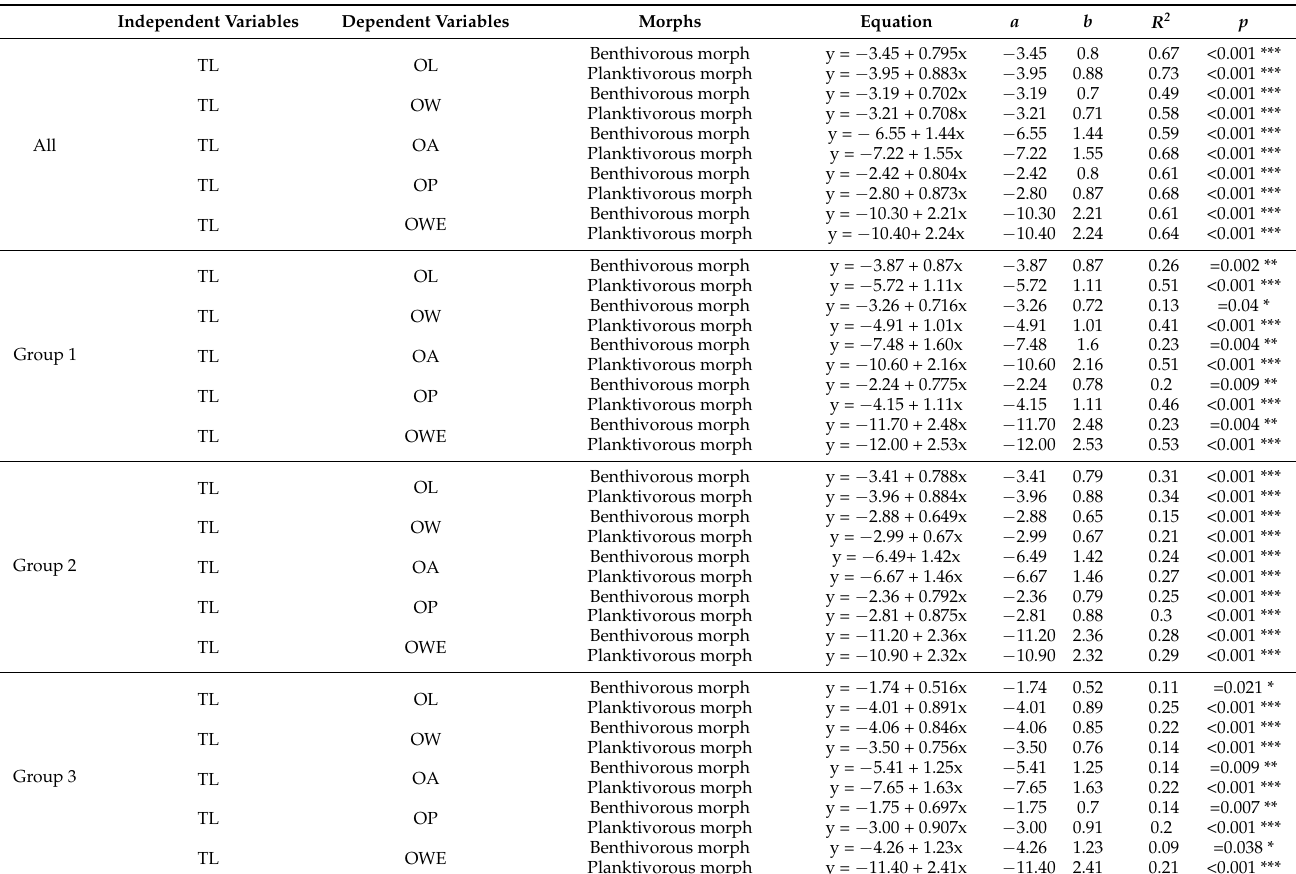
Table 2. The relationship between total fish length (TL) and shape indices (OL, OW, OA, OP, and OWE) (after log transformed) of otolith in the combination of all TL groups, first TL group, second TL group, and third TL group, respectively. Note: a: intercept; b: slope; R 2 : coefficient of determination, *: p < 0.05, **: p < 0.01, and ***: p <